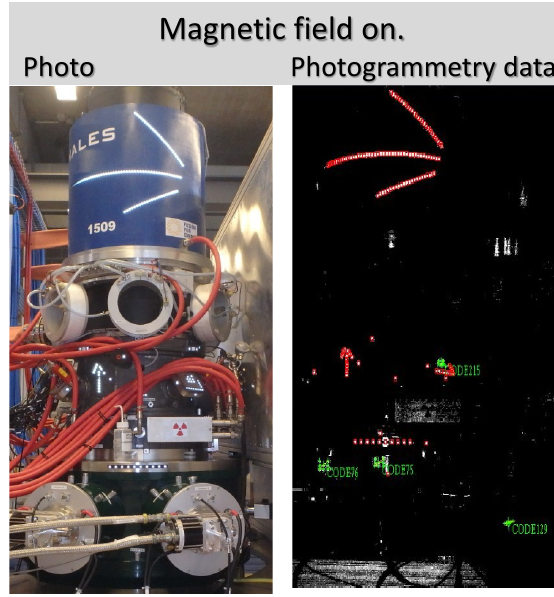
Fig. 13. Left: Photogrammetry targets on the EU gyrotron TH1509. Right: Targets as seen with the photogrammetry camera for data